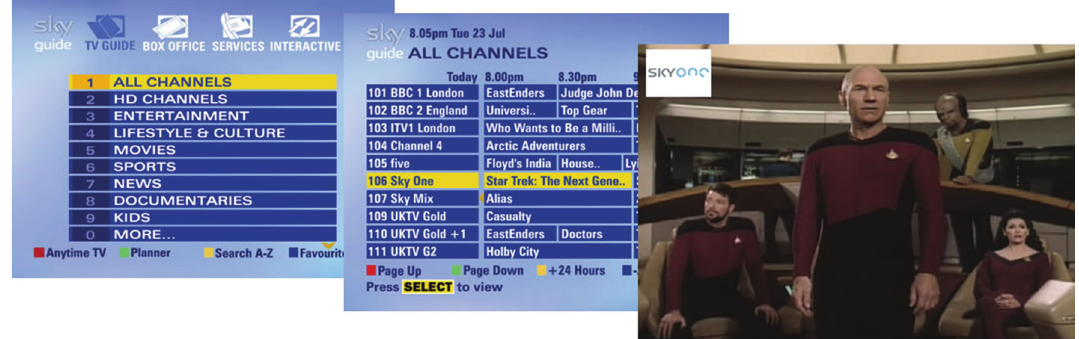
Figure 2: TV Guide from Sky Digital